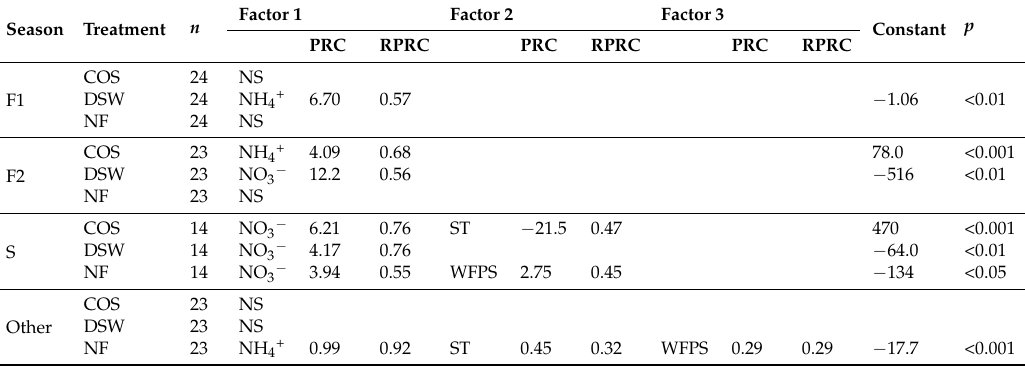
Table 5. Multiple regression analysis of soil nitrous oxide flux and soil temperature (ST), water-filled pore space (WFPS) and soil ammonium (NH 4+ ) and nitrate (NO 3 − ) concentrations in no fertilizer (NF), combined organic and synthetic fertilizer (COS), and distilled silage waste (DSW) treatments in a citrus orchard in southwestern